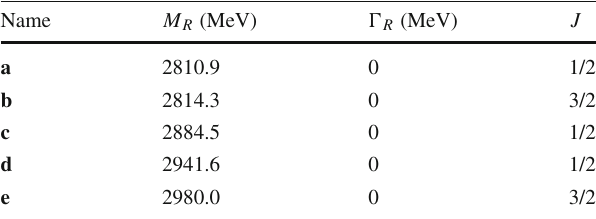
Table 1 (cid:2) c an (cid:2) ∗ c states, reported in Ref. [38], coming from the most attractive SU ( 6 ) lsf × HQSS representations. We label those states from a to e , according to their position in